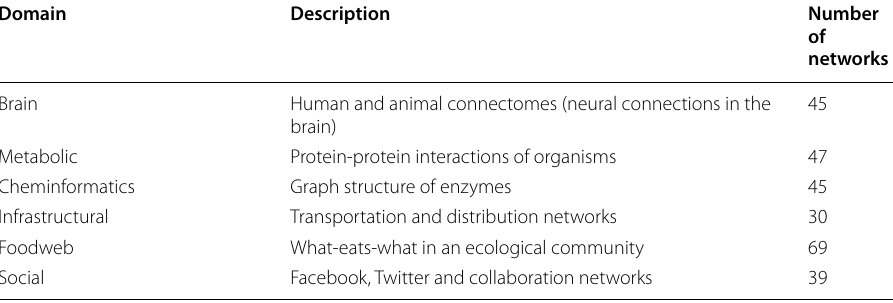
Table 3 Description of the network domains and the number of collected networks Domain Description